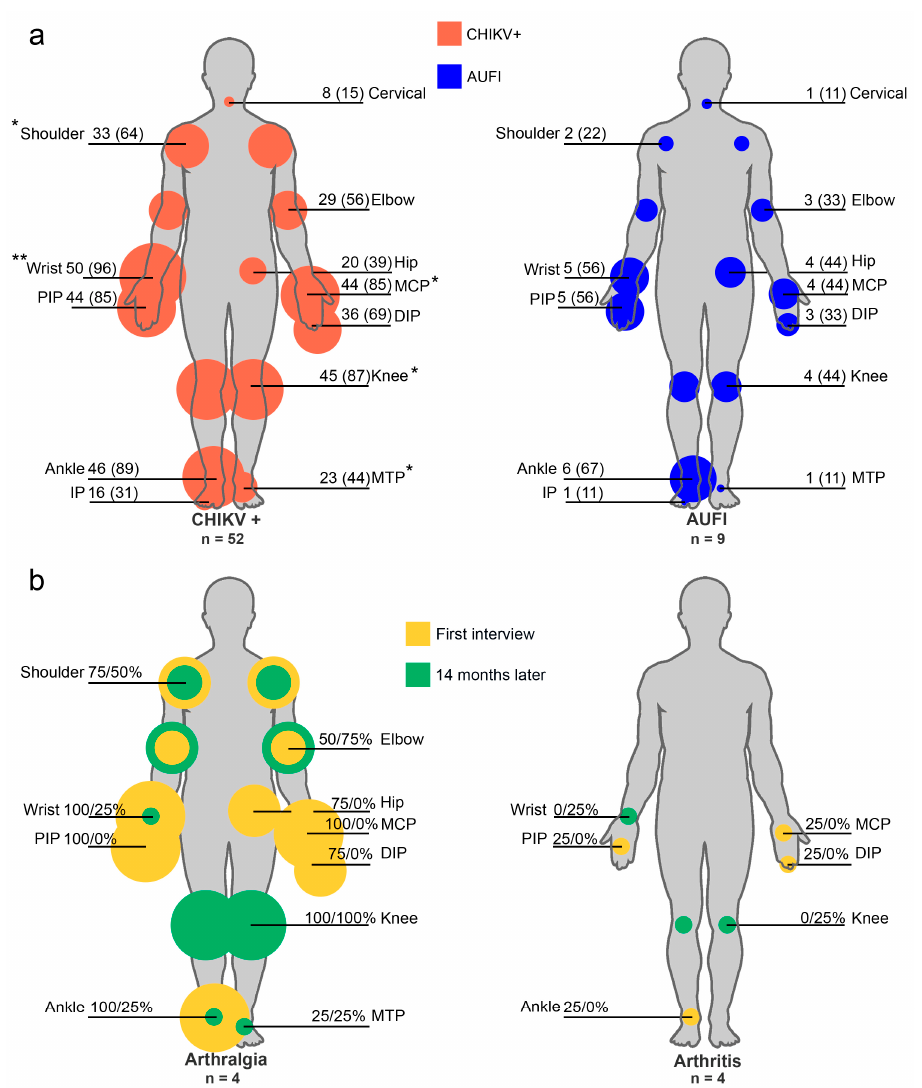
Figure 2. Arthralgia and arthritis distribution in the studied patients from Tapachula, Chiapas, June through July 2015. ( a ) Arthralgia distribution in the CHIKV+ and AUFI patients. The reported arthralgia was symmetrical. For illustrative purposes only, unilateral joints are indicated. Values are no. (%) patients; ( b ) Arthralgia and arthritis distribution on the first interview and after 14 months in the four studied patients. Values are % of patients in the first and second interview. CHIKV+, positive for chikungunya virus infection; AUFI, acute undifferentiated febrile illness; MCP, metacarpophalangeal joint; PIP, proximal interphalangeal joint; DIP, distal interphalangeal joint; MTP, metatarsophalangeal joint. * p < 0.05, ** p < 0.01, Fisher exact